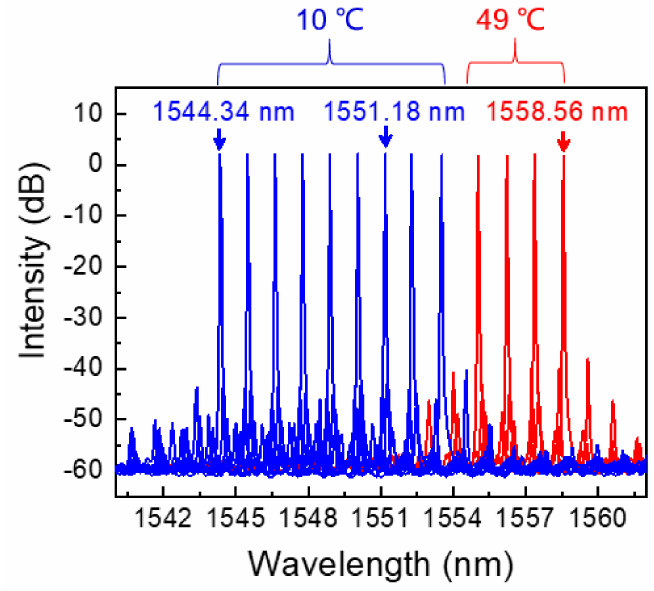
Figure 3. Typical optical spectra of the DBR laser at 10 and 49 ◦ C.